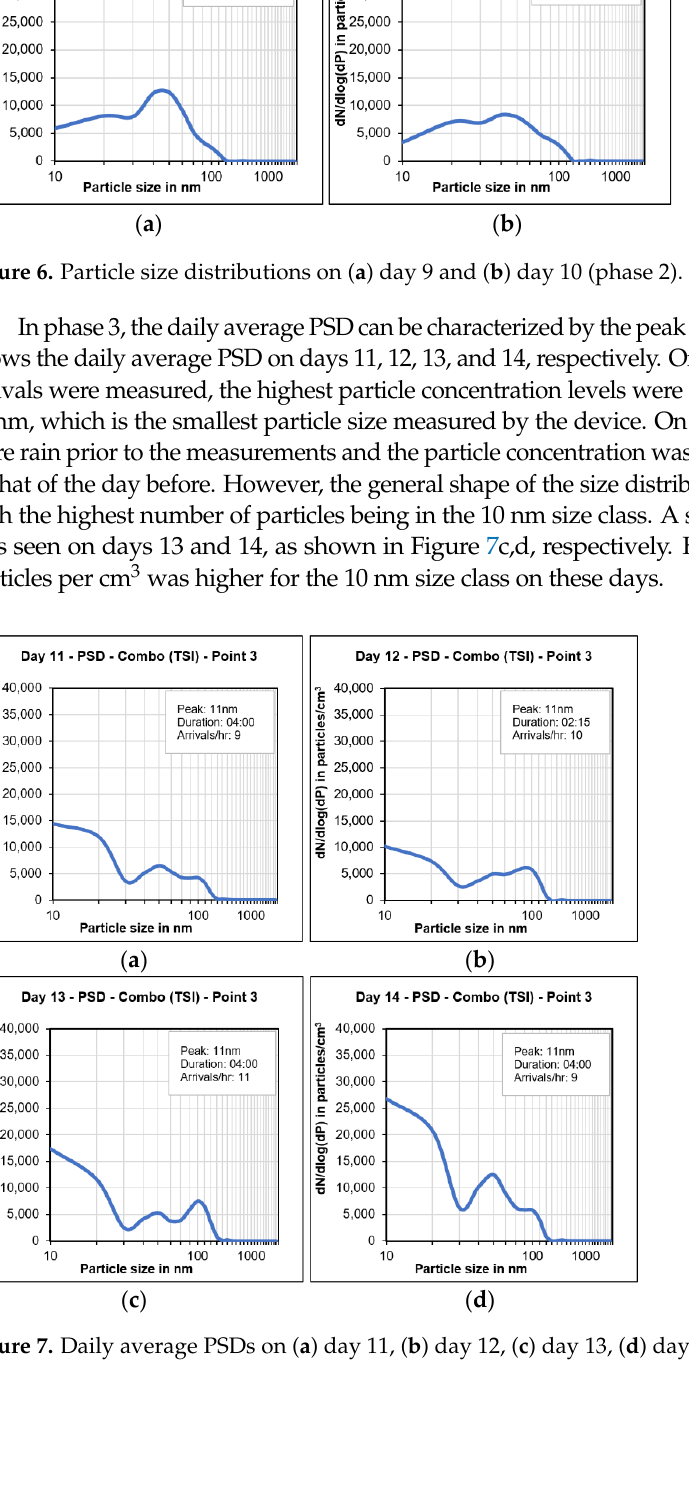
Figure 5. PSD for ( a ) day 1, ( b ) day 2, ( c ) day 3, and ( d , e ) day 4 (phase 1). Beginning in phase 2, a higher number of particles in smaller size classes was ob- served compared to that in phase 1. On day 9, in which most flight arrivals occurred in phase 2, the maximum number of particles occurred in size classes smaller than 36 nm and there was an increase in the particle number concentration (PNC) to about 12,000 particles/cm 3 , as shown in Figure 6a. On day 10, the same location was measured, but the number of flights per hour decreased from ten to four. The overall PNC was lower at just over 8000 particles/cm 3 , but the peak particle concentration occurred at 27 nm (Figure 6b). The lower peak particle size, compared to that in phase 1, could be caused by the aircrafts influencing the concentrations on the ground, but not very much, due to the few numbers of aircrafts starting and landing in phase 2.